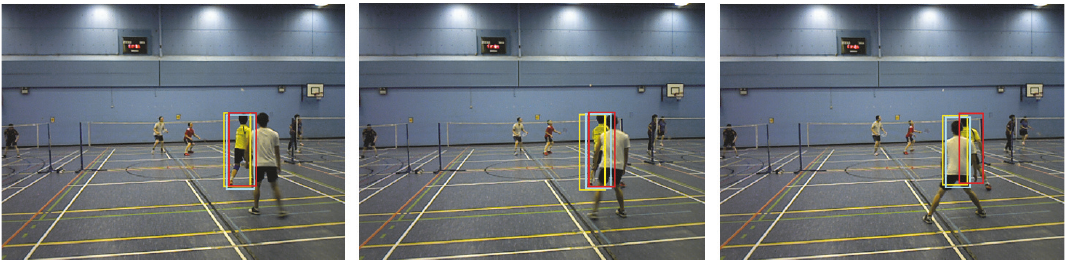
Figure 2: The comparison results on athlete move video from BTB dataset.